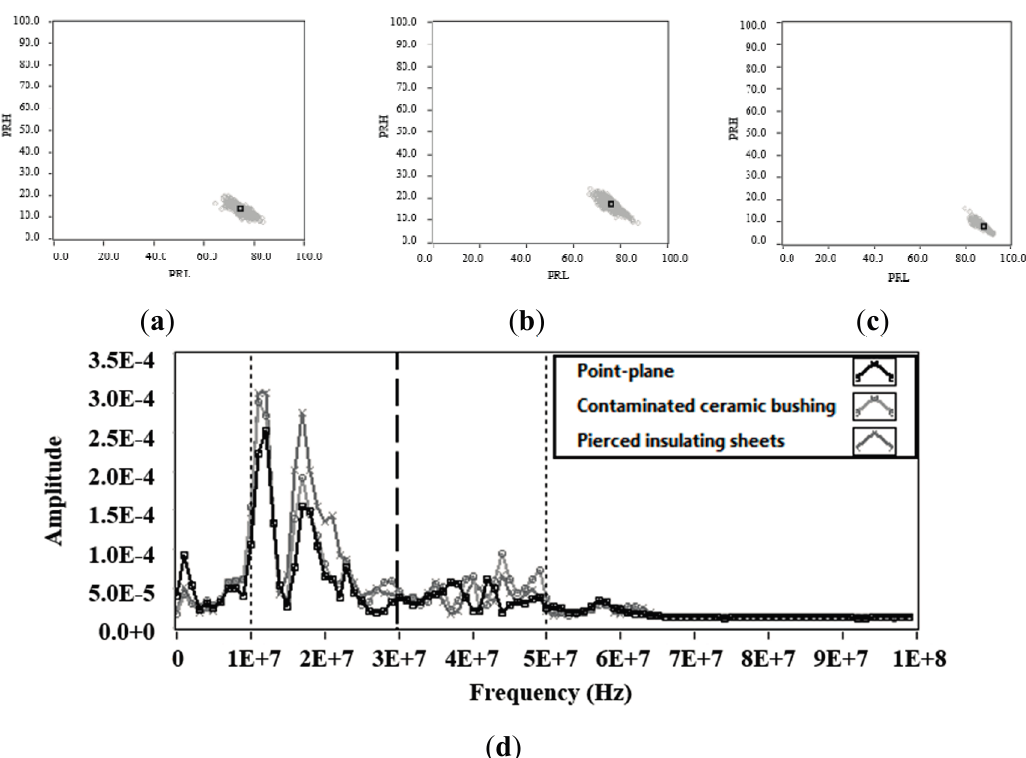
Figure 6. Noise acquisition 800 V. ( a ) Power ratio map for noise signals in the point-plane experimental test object; ( b ) Power ratio map for noise signals in a contaminated ceramic bushing; ( c ) Power ratio map for noise signals in pierced insulating sheets; ( d ) Average spectral power of the signals obtained with the three test